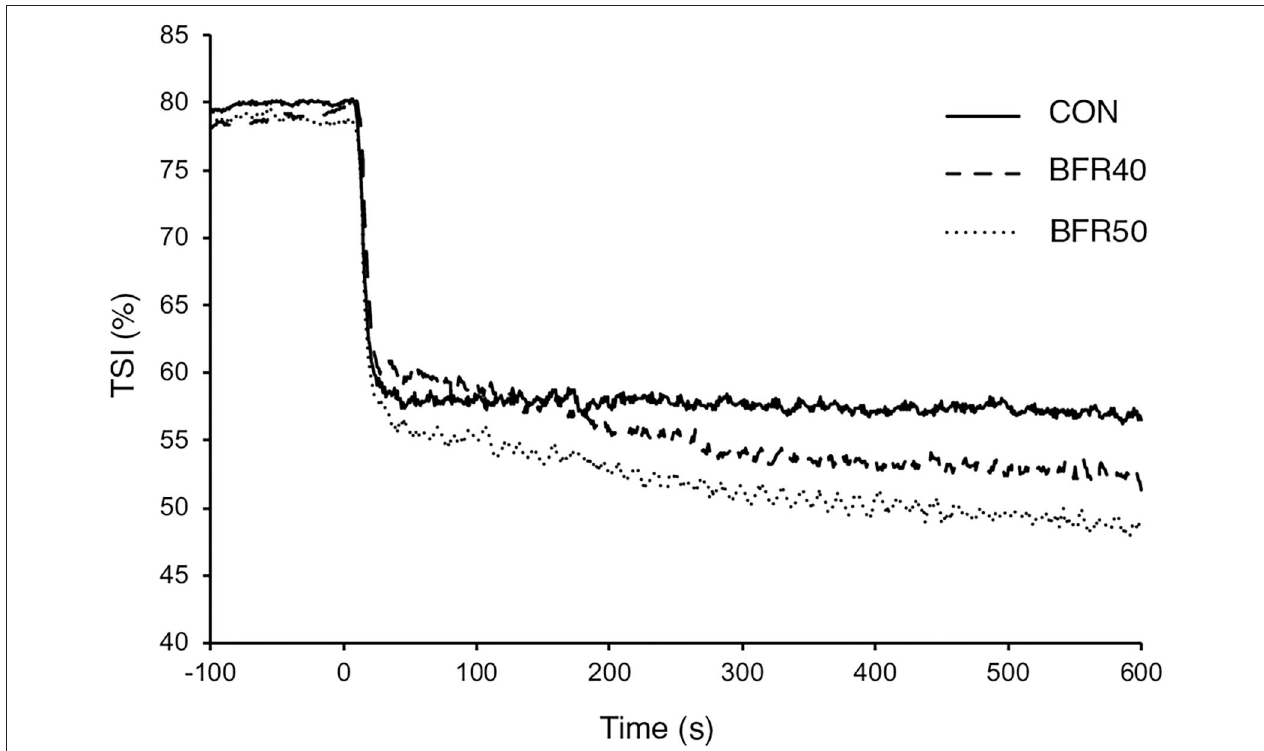
FIGURE 3 | Tissue saturation index for exercise without blood flow restriction (CON), with 40% (BFR40) or 50% (BFR50) occlusion for a representative